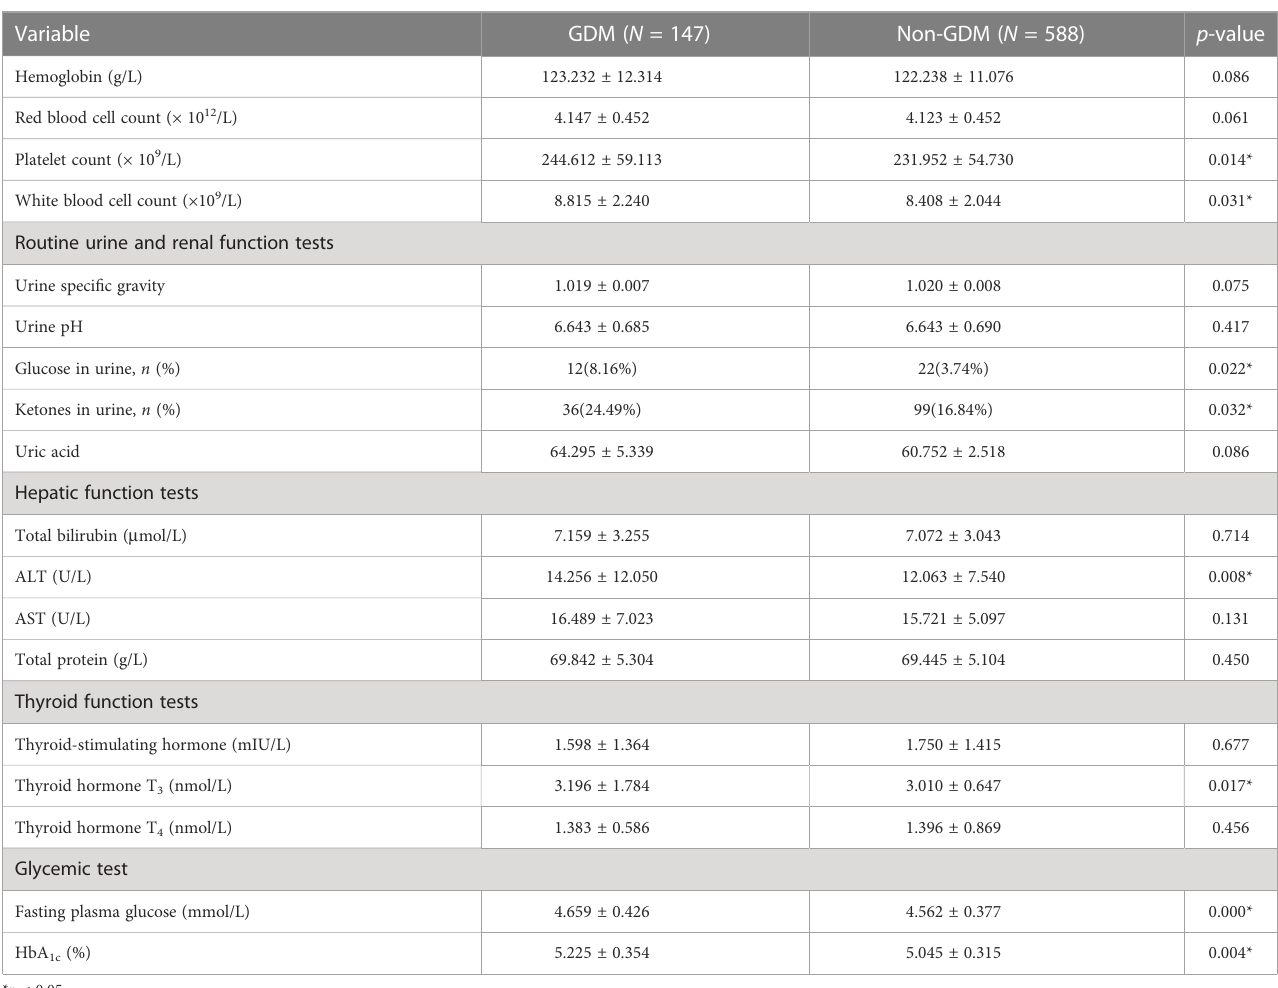
alanine aminotransferase, thyroid hormone T 3 , fasting plasma glucose, and glycated hemoglobin (HbA 1c ), were also higher in women with GDM than in control participants. The demographic characteristics, clinical features, and laboratory parameters of participants in the training and testing sets are compared in Table 2. Good consistency in the data between the training data set and the testing data set is shown for the majority of the variables.